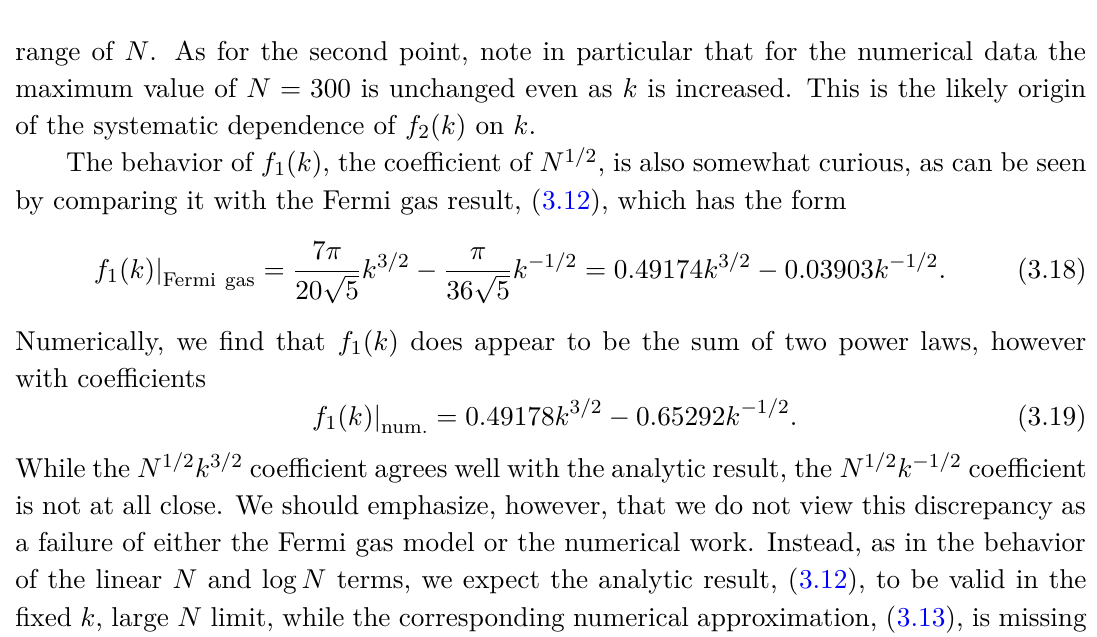
Table 1 . The coefficients f 1 ( k ) and f 2 ( k ) for the real component of the numerically determined free energy, (3.17), and g 1 ( k ) for the imaginary component, (3.20), for k = 1 , . . . , 10 . The fit is obtained from data for N = 140 to 300 in steps of 20